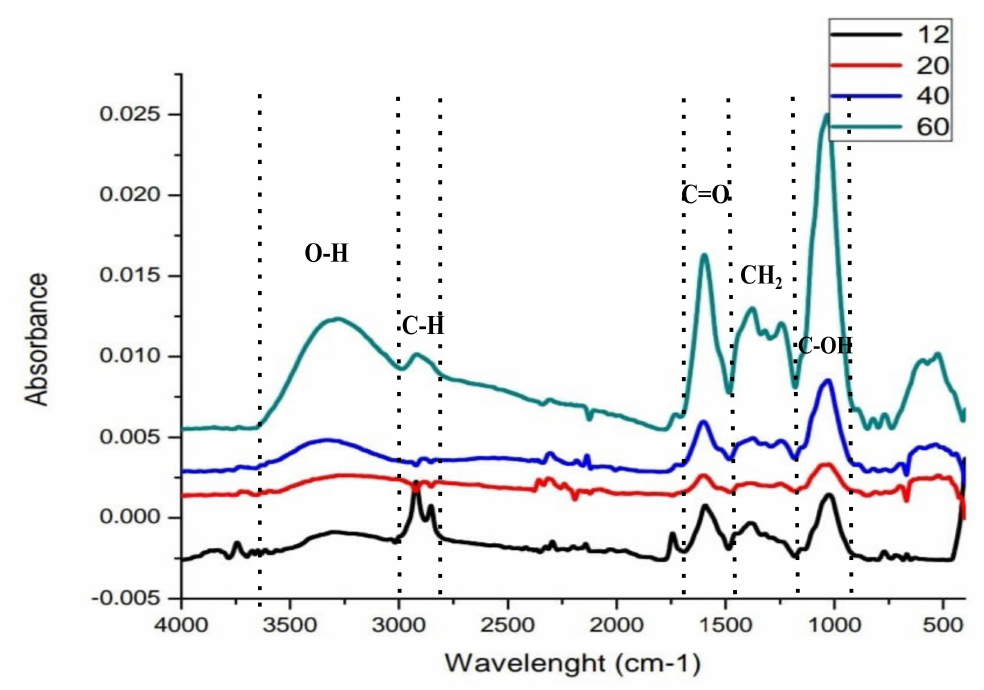
Figure 4. FT-IR spectrograms of different particle sizes from pecan pericarp residues, indicating the stretching of the signals corresponding to the most representative functional